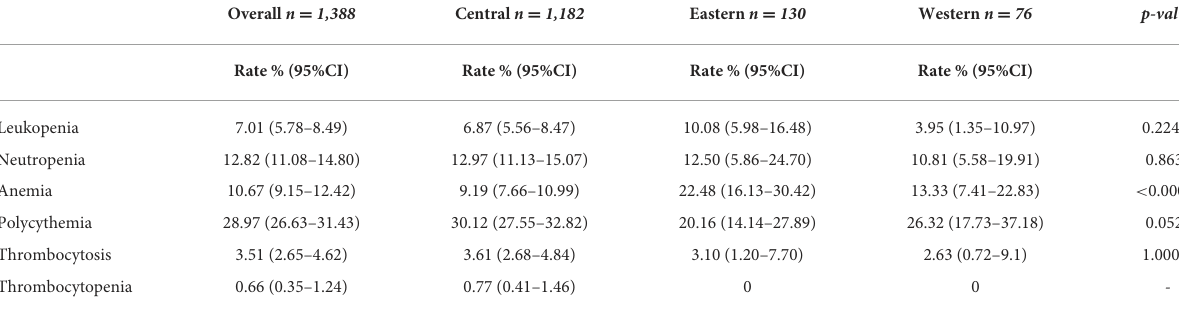
TABLE 5 Prevalence rate of leukopenia, neutropenia, anemia, polycythemia, thrombocytosis, and thrombocytopenia by